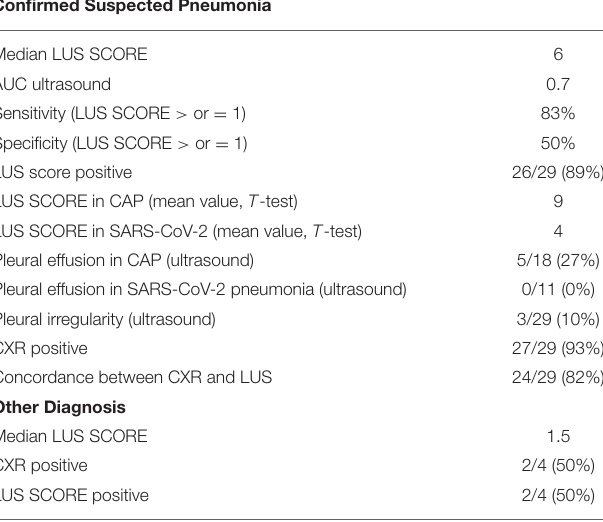
TABLE 2 | Statistical data of the two groups.